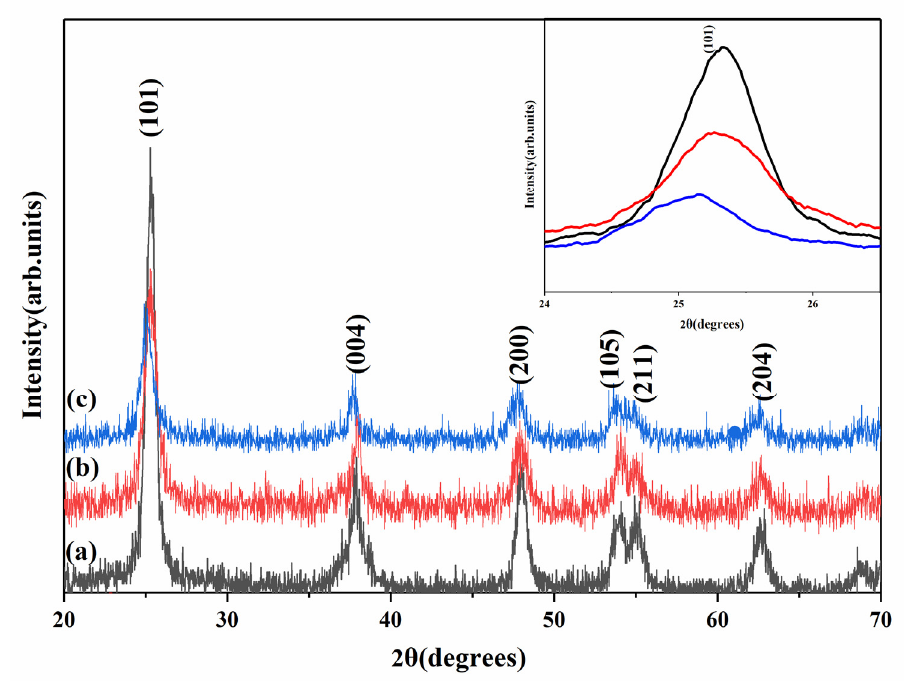
Figure 4. XRD patterns for ( a ) TiO 2 , ( b ) TiO 2 ‐ Eu 3+ , ( c ) TiO 2 ‐ ETP.